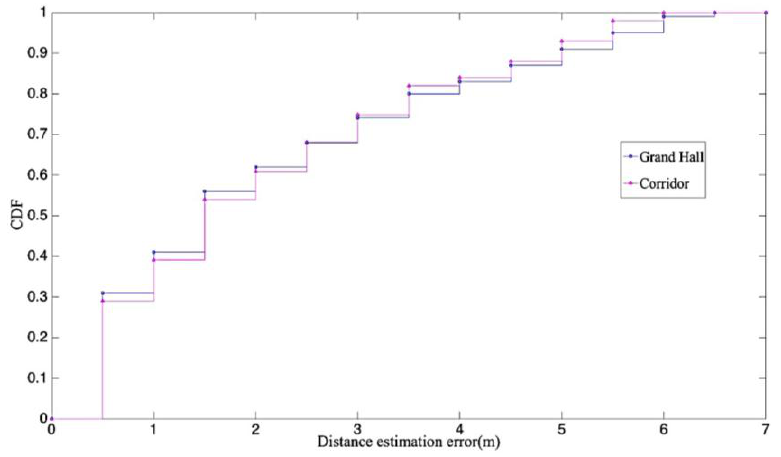
Figure 9. The field experiments on the two environments.